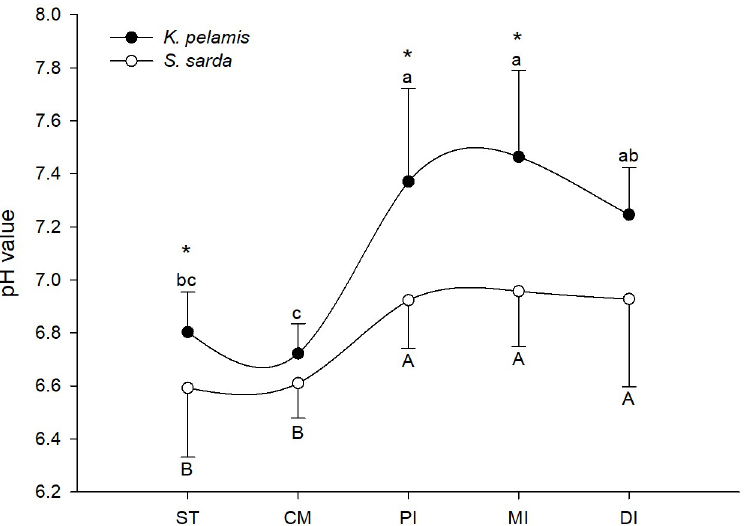
Fig 2. Digestive organs pH values. pH values of stomach (ST), caecal mass (CM), proximal intestine (PI), middle intestine (MI) and distal intestine (DI) of Katsuwonus pelamis (black dots) and Sarda sarda (white dots). Data are presented as mean ± SD (n = 10). Different lowercase letters (a, b, c) represent statistical differences between digestive organs of S . sarda , while different capital letters (A, B) represent statistical differences between digestive organs of K . pelamis (P < 0.05). Asterisks represent statistical differences between species (P < 0.05). Absence of asterisk indicates no statistical difference between species (P > 0.05).